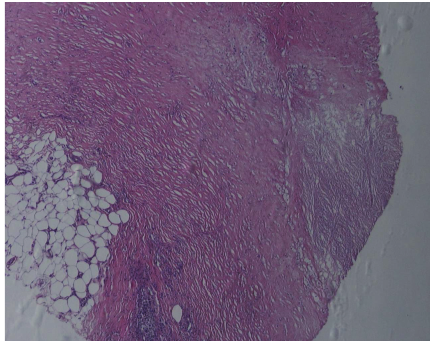
Figure 4: Necrotic areas with collagenous degeneration in deep dermis, peripheral fibrosis, and subcutaneous tissue panniculitis (H&E ×